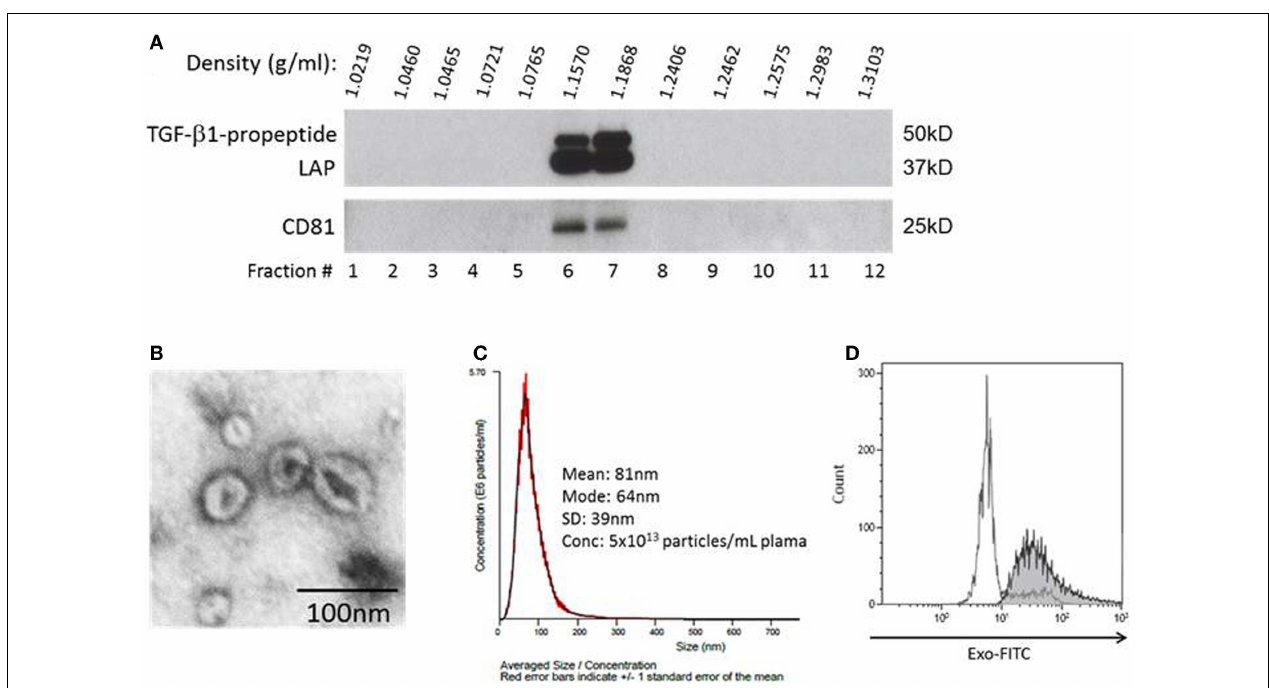
instrument to determine their size and particle concentration. (D) Flow cytometry of AML plasma-derived exosomes (30 µ g protein) captured on streptavidin and biotinylated anti-CD81 Ab-coated magnetic beads and visualized with the EXO-FITC dye. Gate was set on single beads.The white peak shows beads without exosomes, while the shaded peak shows beads carrying exosomes visualized with the EXO-FITC dye. A representative experiment of three performed with exosomes captured from different AML patients’ plasma is